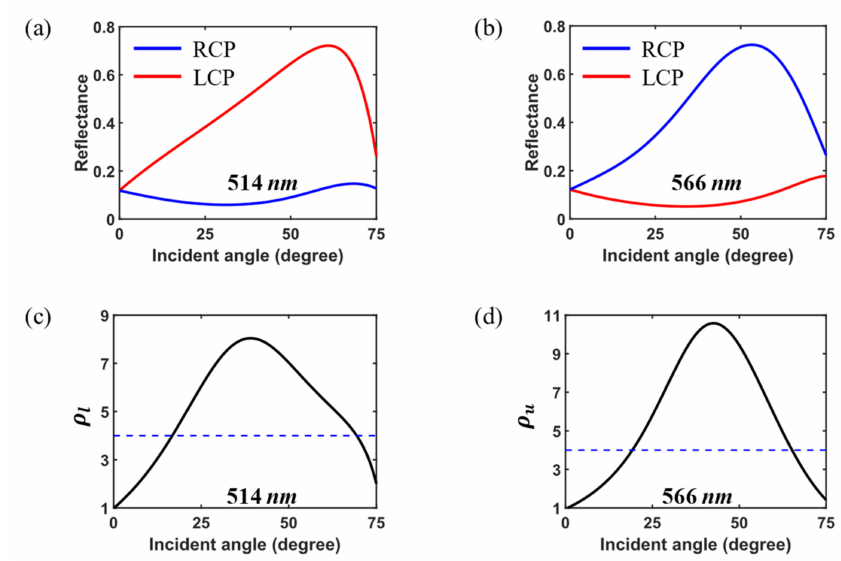
Figure 5. Reflectance for LCP and RCP waves at ( a ) λ = 514 nm and ( b ) λ = 566nm, respectively. The blue (red) dotted line represents the reflectance of LCP (RCP) wave. Polarization selection ratio versus incident angles at ( c ) λ = 514 nm and ( d ) λ = 566 nm, respectively. The blue dashed lines indicate ρ =